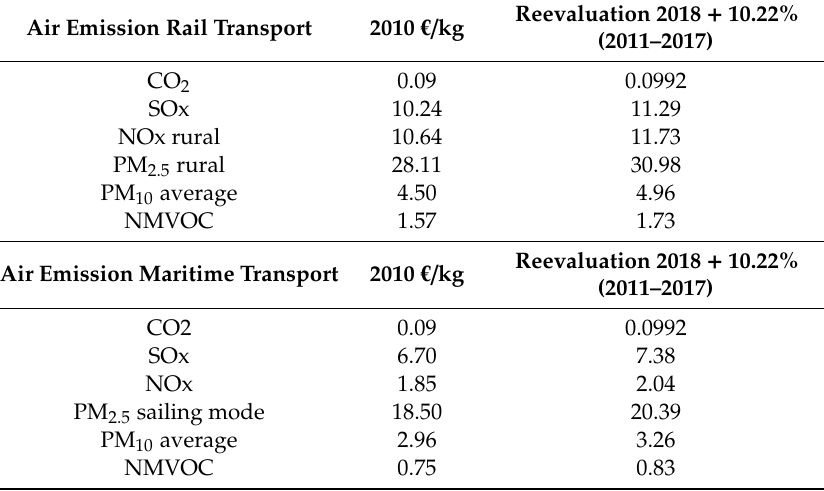
Table 1. Unit prices of pollutants used in the research [7].